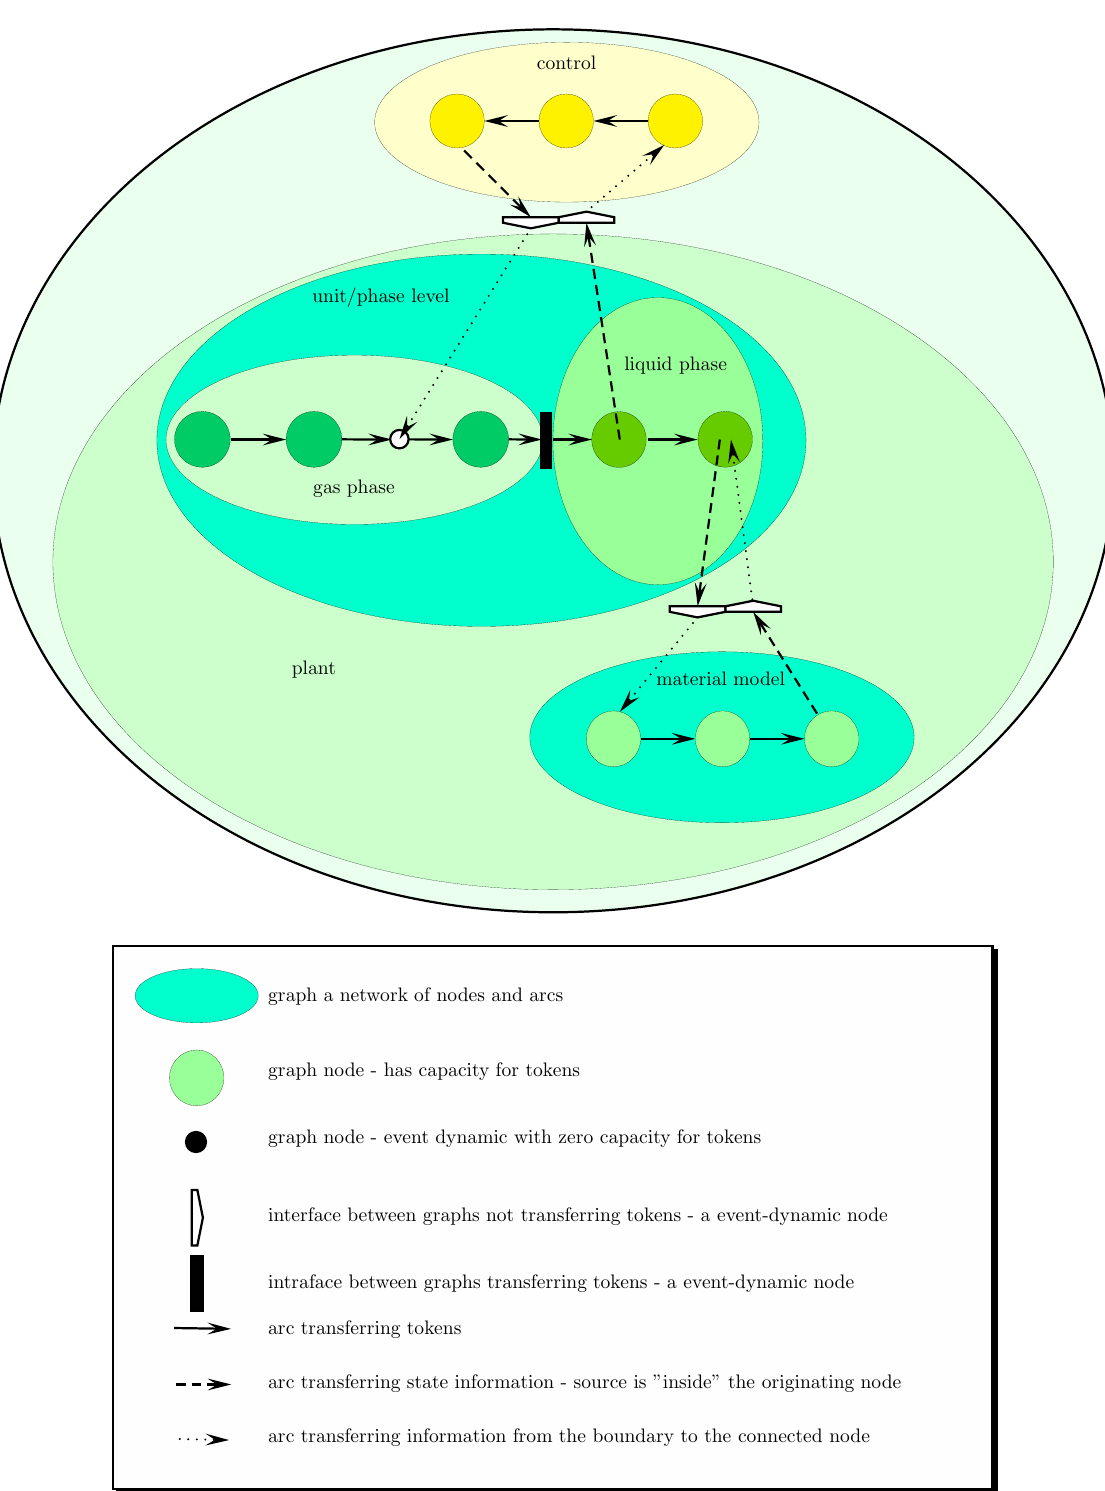
Figure 1. Network of networks representation of multi-disciplinary model